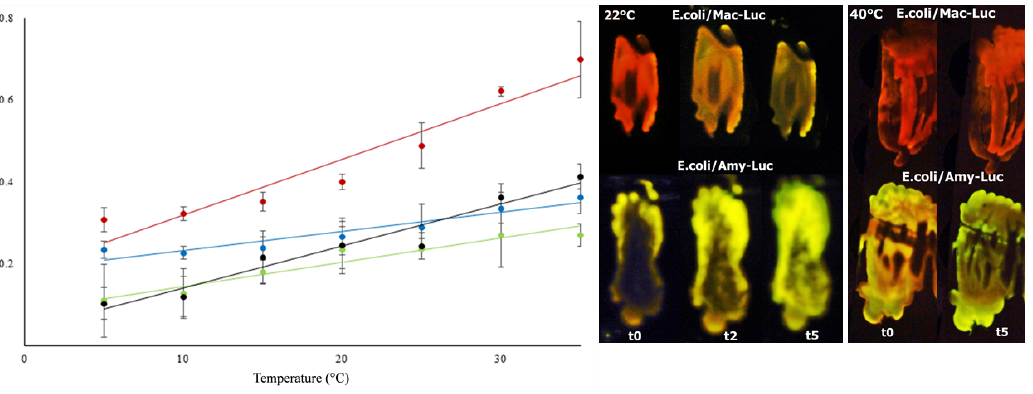
Figure 9. Comparison of the effect of temperature on the ratio of bioluminescence color of beetle luciferases: ( left graph ) ratiometric estimation of temperature using distinct firefly luciferases. (red) Macrolampis sp2; (black) Photinus pyralis ; (green) Cratomorphus distinctus, and (blue) Amydetes viviani ; ( right images ) in vivo bioluminescence color of E.coli colonies expressing Macrolampis sp2 (Mac-Luc) and Amydetes viviani (Amy-Luc) luciferases, after spraying D-luciferin, at 22 and 40 °C. Reprinted with permission from ref. [85]. Copyright 2014 Royal Society of Chemistry. One can see that the luciferases with steeper curves such as Macrolampis luciferase (red) are the most sensitive to temperature, and those with less steep curves, such as Amydetes viviani luciferase (blue), are the least sensitive.